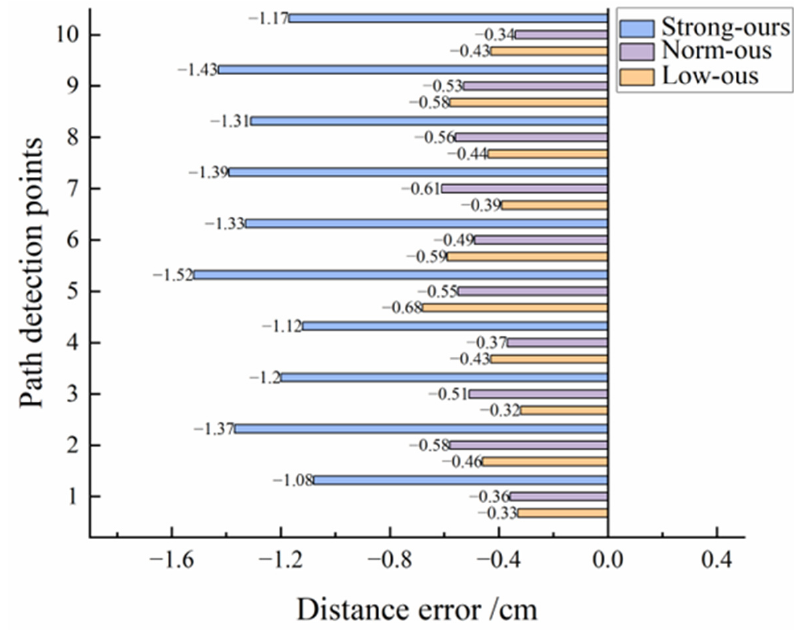
Figure 10. Distance error comparison.